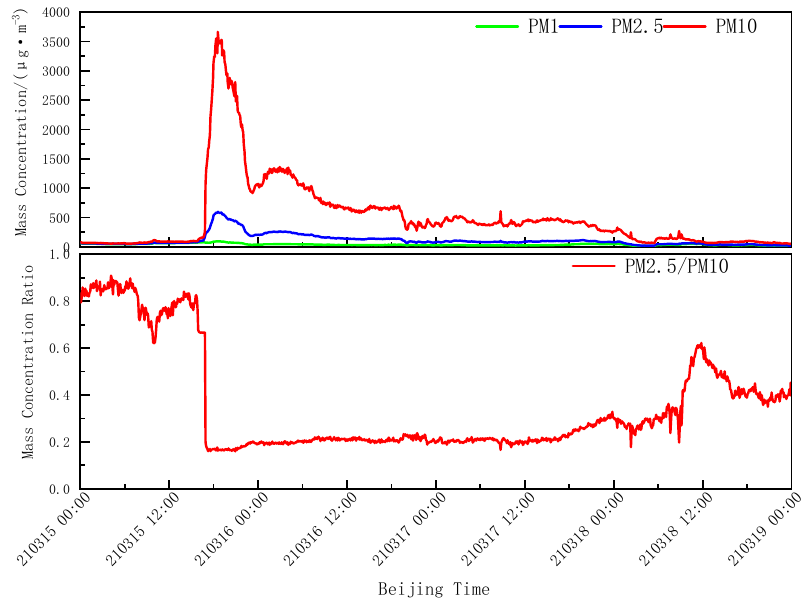
Figure 9. Mass concentration of PM1, PM2.5 and PM10 (the upper), and mass concentration ratio of PM2.5 to PM10 (the lower).